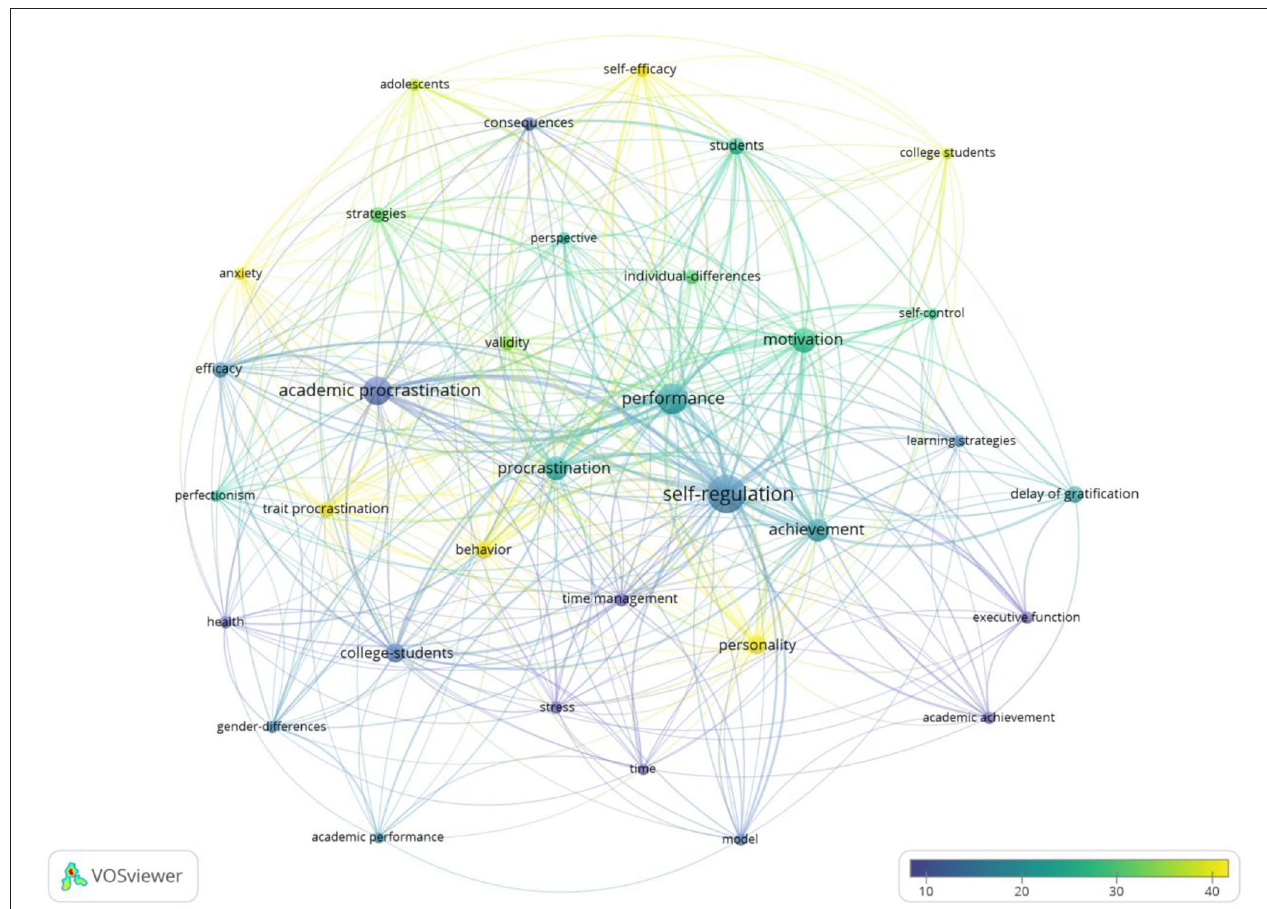
FIGURE 9 | Overlay visualization based on self-regulation link-weights and citation